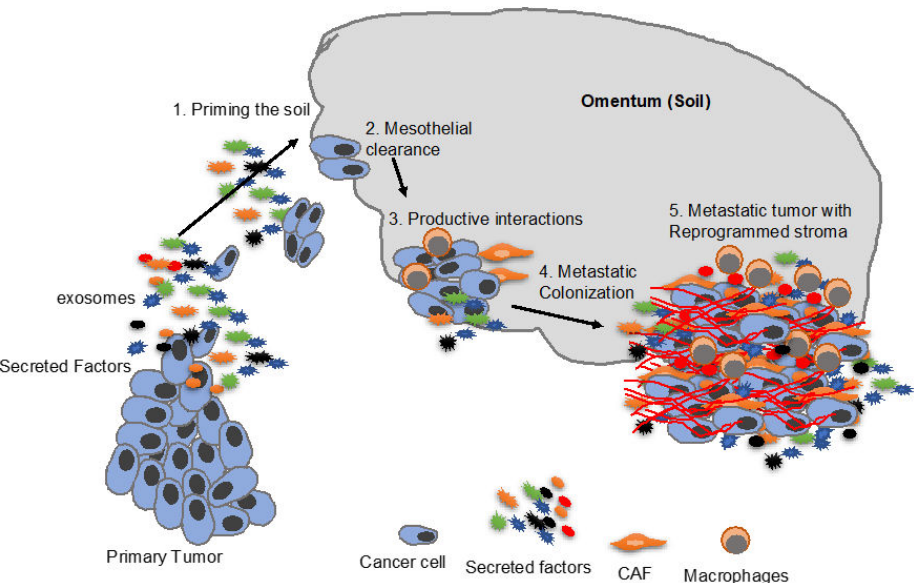
Figure 2. An overview of ovarian cancer metastatic colonization. Starting with priming of the metastatic niche by secreted factors, including exosomes, from the primary tumor (1), followed by mesothelial clearance (2) and reciprocal interactions between cancer cells and the microenvironment. This eventually results in metastatic colonization (4) and reprogramming of the stroma into an ‘activated’ tumor-promoting stroma